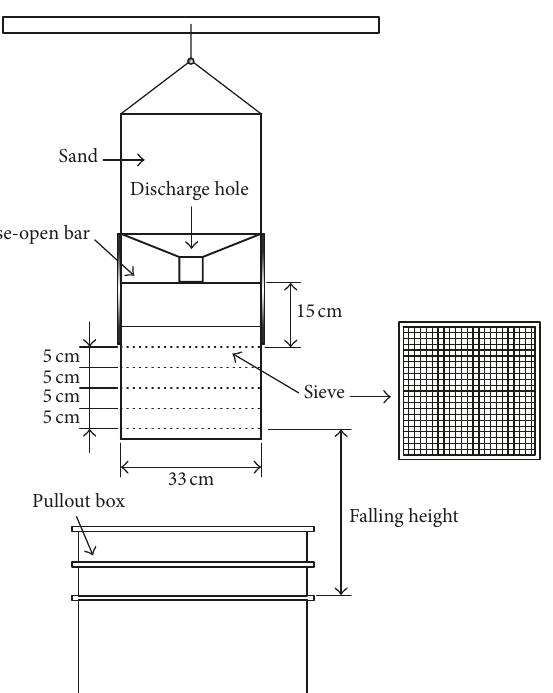
Figure 6: Multiple sieving pluviation apparatus